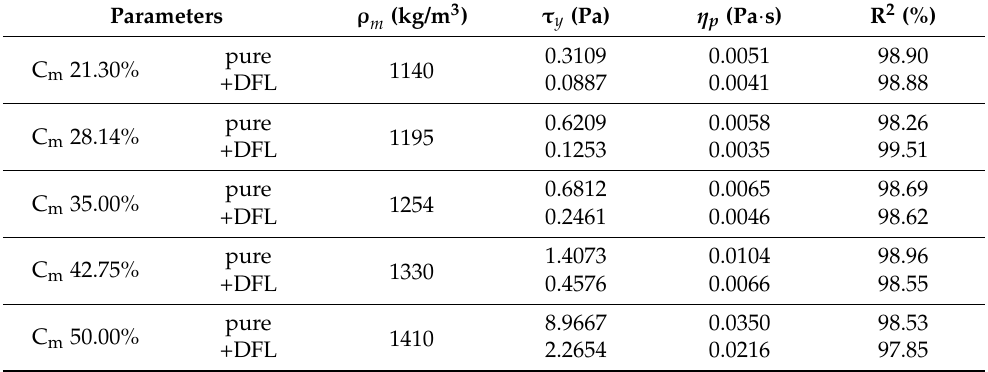
Table 2. Rheological parameters of the tested hydromixtures.